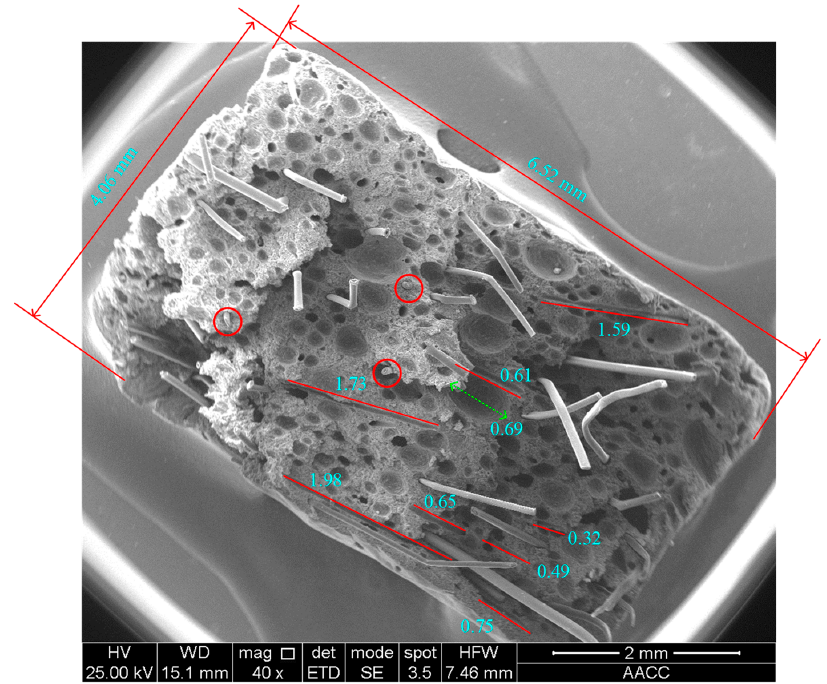
Figure 13. Scanning electron micrograph of a fracture surface.